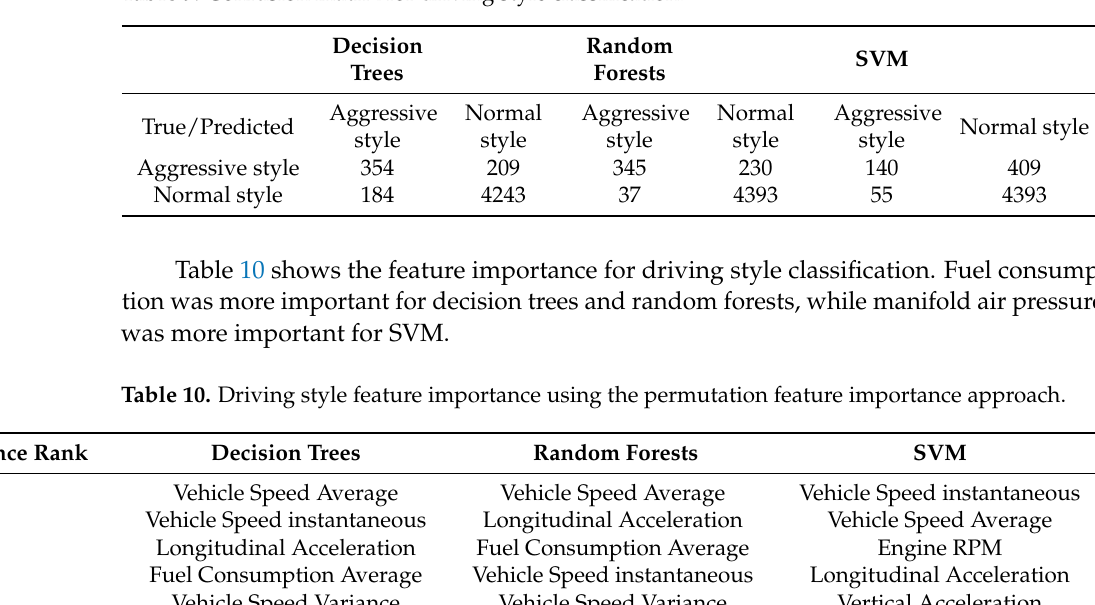
Table 9. Confusion matrix for driving style classification.